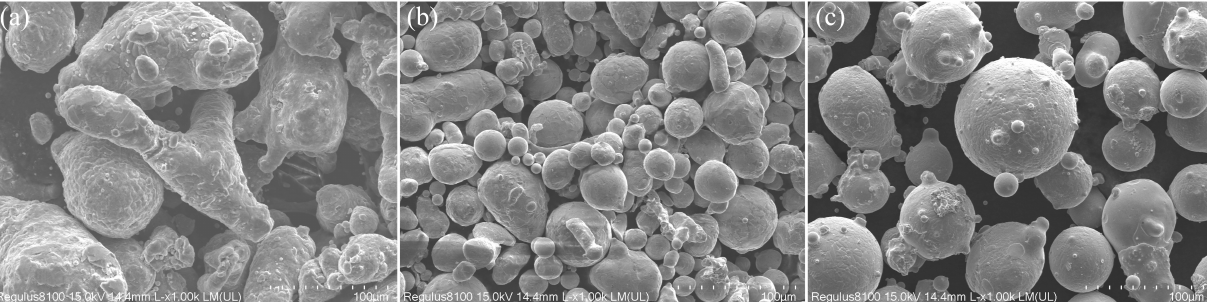
Figure 2. SEM images of the ( a ) Al power morphology, ( b ) Ni powder morphology, and ( c ) CoCrMo powder morphology. Table 1. Batch numbers of the samples prepared at different powder feeding speeds. Batch